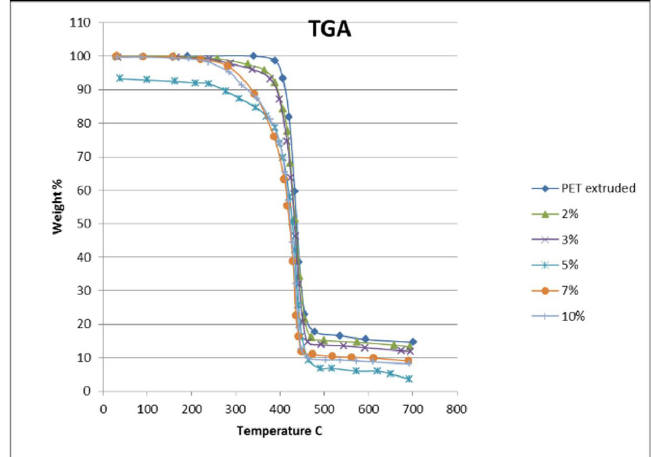
Figure 6. TGA data for prepared PET-IL blends.